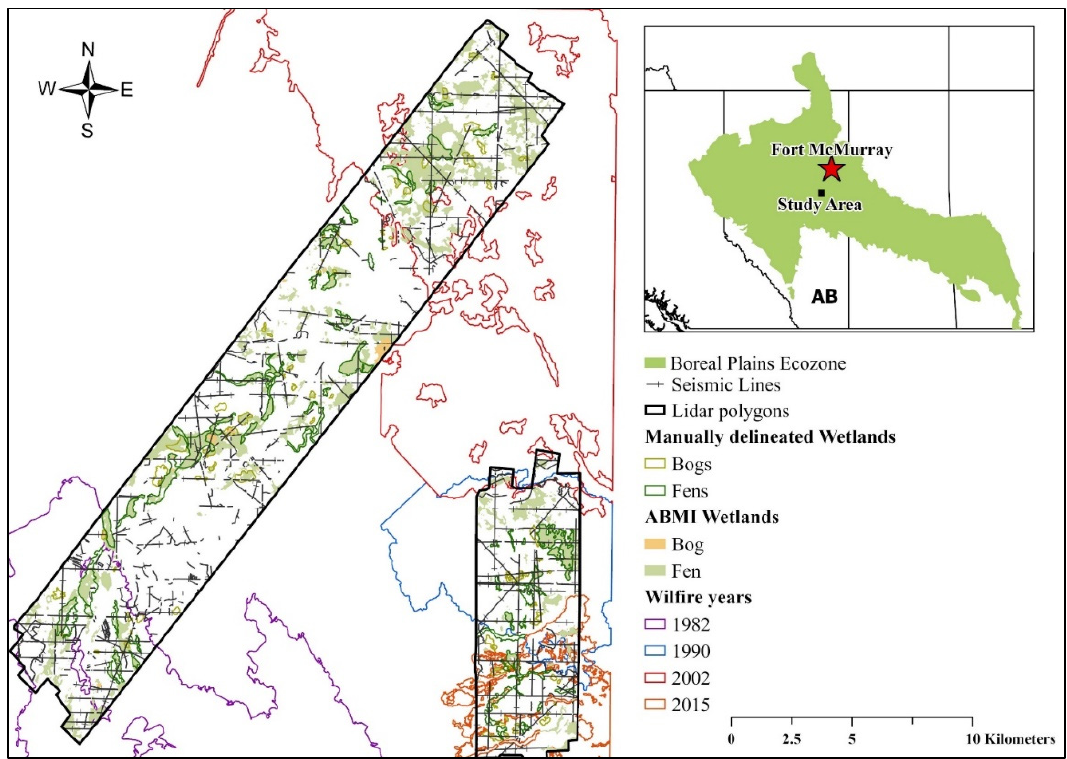
Figure 1. Location of 5 years, 18 years, 30 years, and 38 years since fire chronosequence near Fort McMurray, Alberta surveyed using multi-spectral lidar. The region is within the Boreal Plains ecozone. Areas that have not been burned in the recent history of scientific observation (since ~1930) are found in between the fire scars, predominantly between 1982 and 2002 fires in the western lidar polygon.